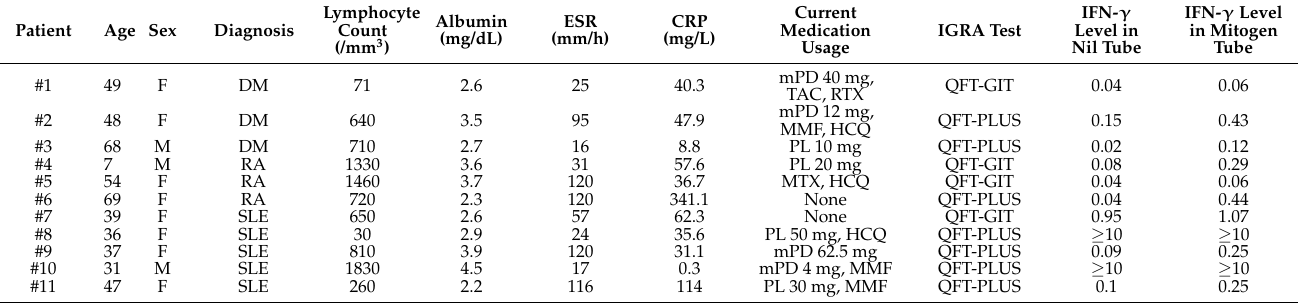
Table 4. Description of patient characteristics with indeterminate IGRA results.